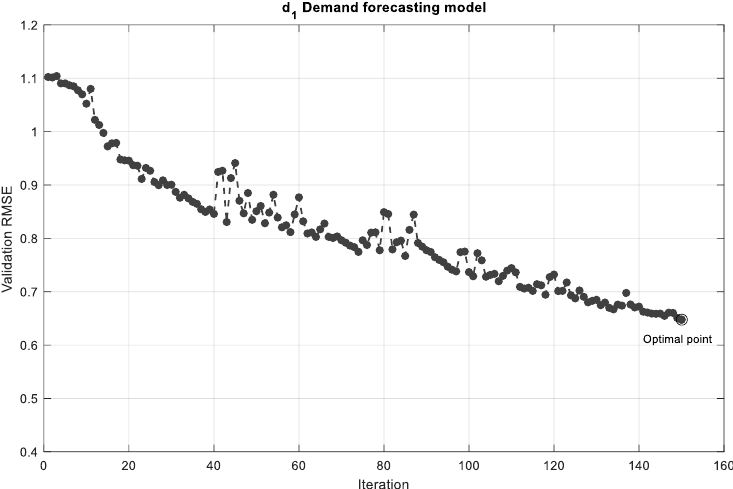
Figure 4. Illustration of the ESC demands time series, approximation, and details vectors obtained using the Daubechies wavelet.